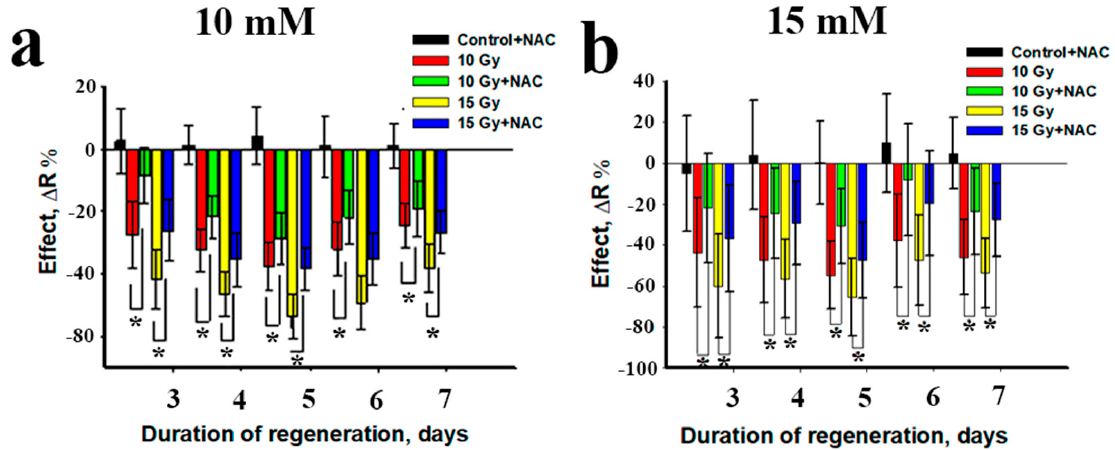
Figure 2. The radioprotective effect of NAC under X-ray exposure. ( a ) Radioprotective effect of N-acetylcysteine (10 mM) under 10 and 15 Gy irradiation; ( b ) radioprotective effect of N-acetylcysteine (15 mM) under 10 and 15 Gy irradiation, * p < 0.001 via ANOVA.